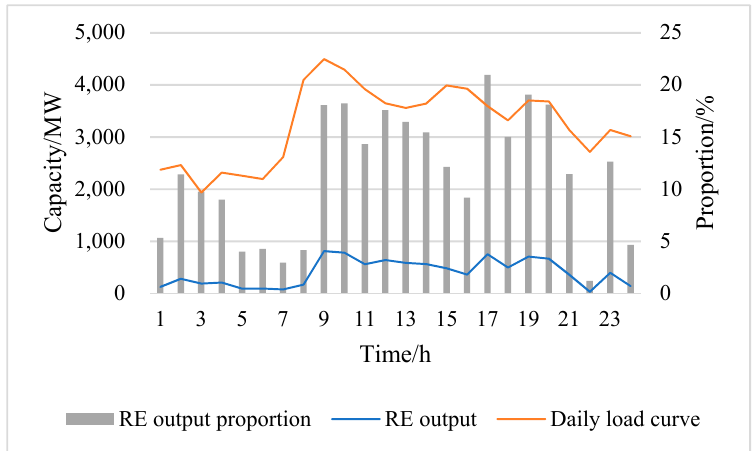
Figure 3. Urban power grid load and new energy prediction curve.